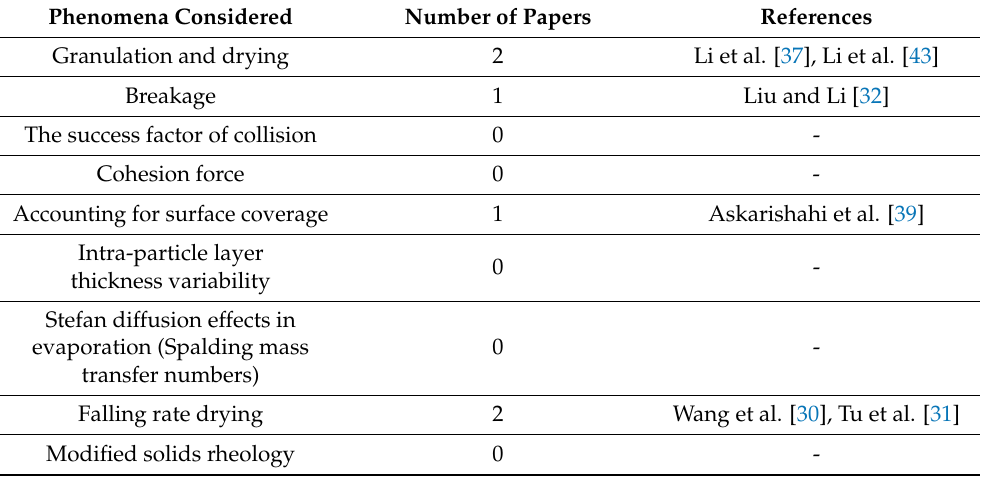
Table 2. Phenomena involved in fluid bed granulation which need to be addressed in the TFM